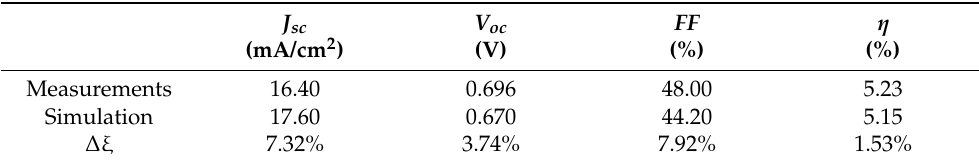
Figure 2. The illuminated J – V curve of the simulated device vs measurements. Table 3. Main performance parameters and absolute error between simulation results compared with